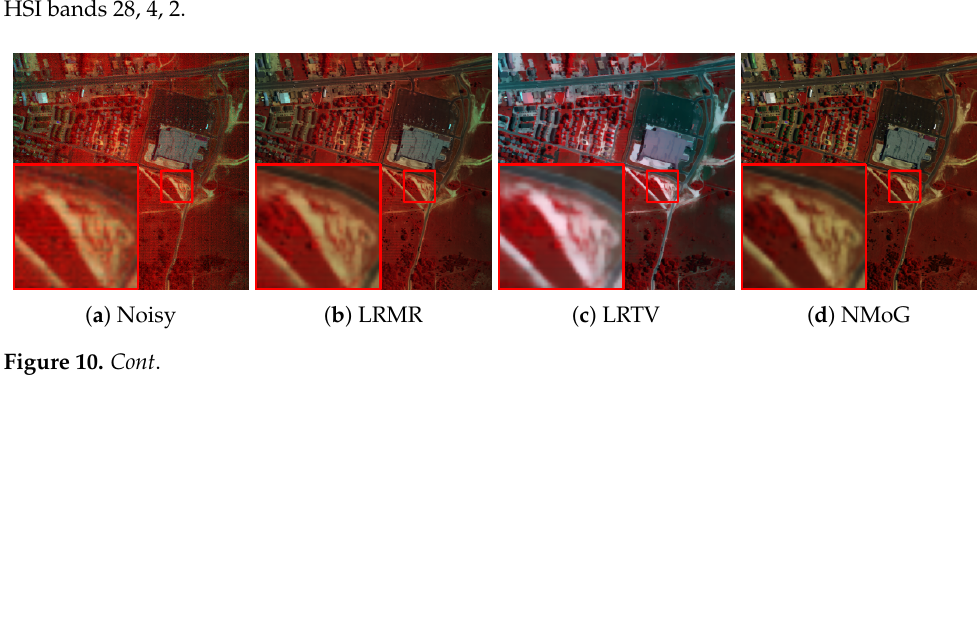
Figure 9. Classification quantitative (OA) and qualitative results of Indian Pines dataset. DIBD-R denotes DIBD training on both labeled and unlabeled mixed data. The RGB image is synthesized by HSI bands 28, 4, 2.